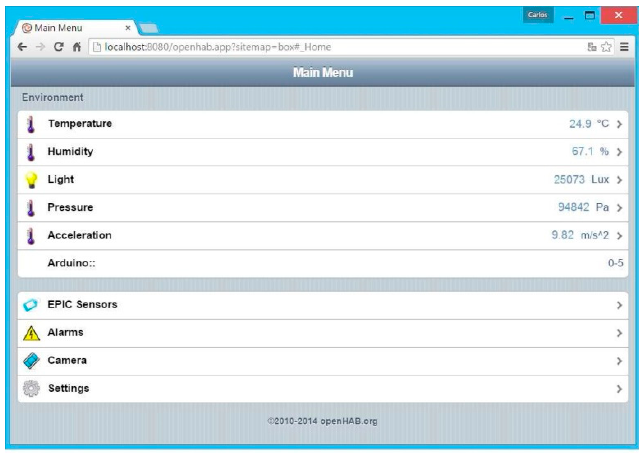
Figure 11. Screenshot of the “main menu” developed for the transport box.